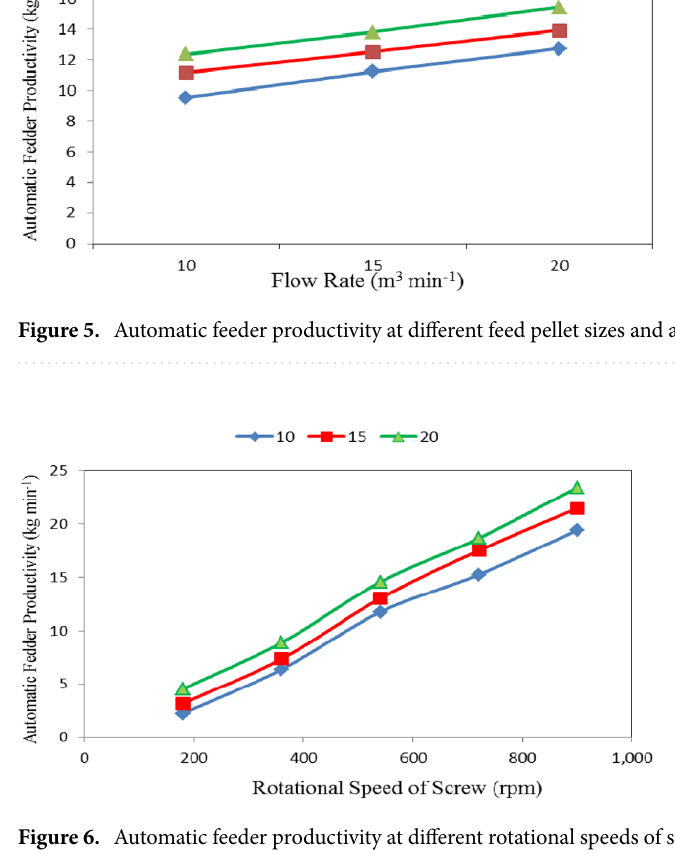
Figure 6. Automatic feeder productivity at different rotational speeds of screw and flow